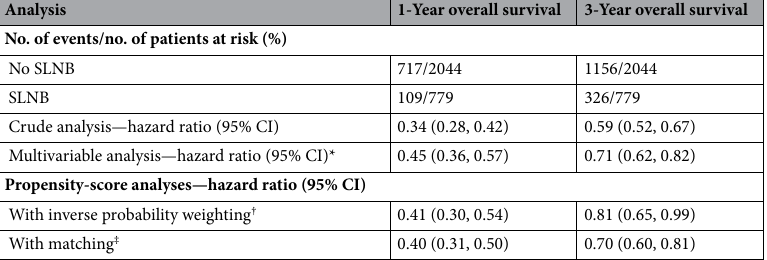
Table 5. Association between SLNB and the End Point of 1-year or 3-year Overall Survival in the Crude Analysis, Multivariable Analysis and Propensity-Score Analyses. *Shown is the hazard ratio from the multivariable Cox proportional-hazards model, with adjustment for age, sex, social economic status, cancer sites, lymph node dissection, diabetes, hypertension, coronary artery disease, stroke, congestive heart failure, cirrhosis, Parkinson disease, COPD, malignancy. The analysis included all 2823 patients. † Shown is the primary analysis with a hazard ratio from the multivariable Cox proportional-hazards model with covariates with inverse probability weighting according to the propensity score. The analysis included 2823 patients. ‡ Shown is the hazard ratio from a multivariable Cox proportional-hazards model with covariates with matching according to the propensity score. The analysis included 2049 patients (1366 without SLNB and 683 undergoing SLNB).